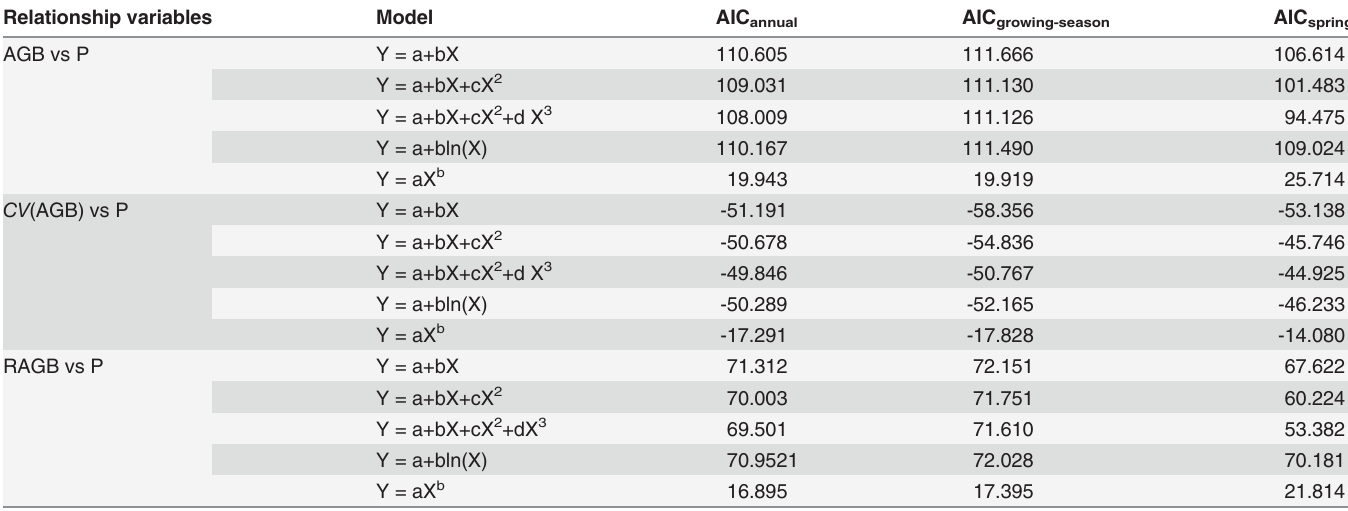
Table 1. List of statistical models with AIC values. Relationship